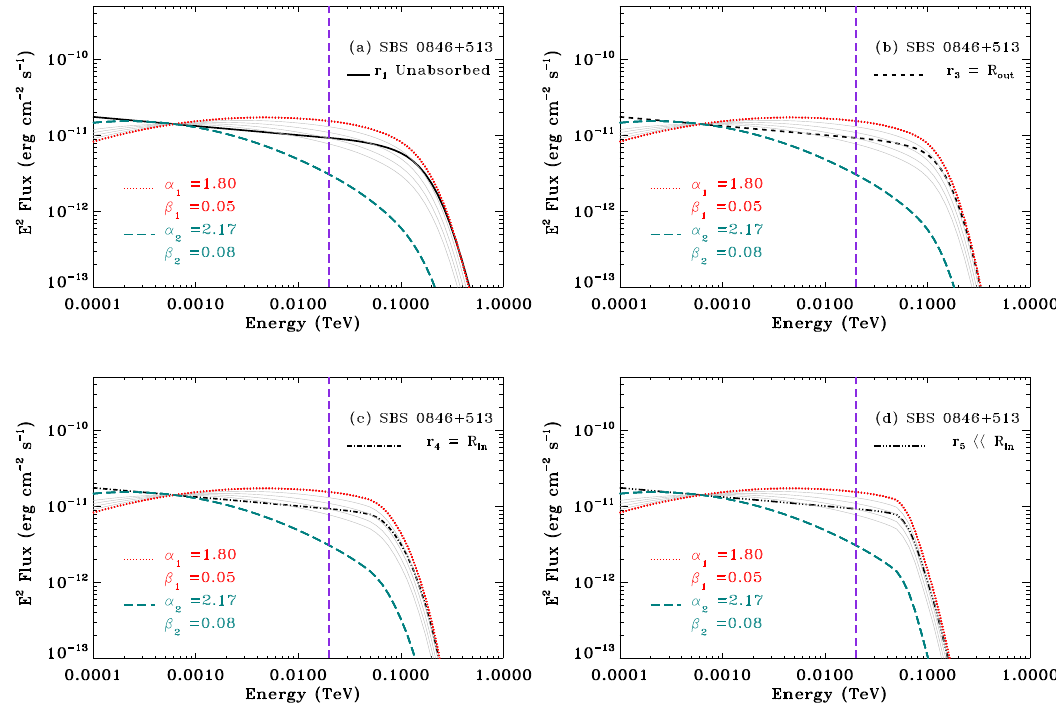
Figure 3. Spectral energy distribution in the energy range 100MeV–1TeV for SBS 0846 + 513. ( a ) R em = r 1 (cid:29) R BLR ; ( b ) R em = r 3 = R out ; ( c ) R em = r 4 = R in ; ( d ) R em = r 5 (cid:28) R in . The vertical purple dashed line at E = 20GeV represents the CTA energy lower